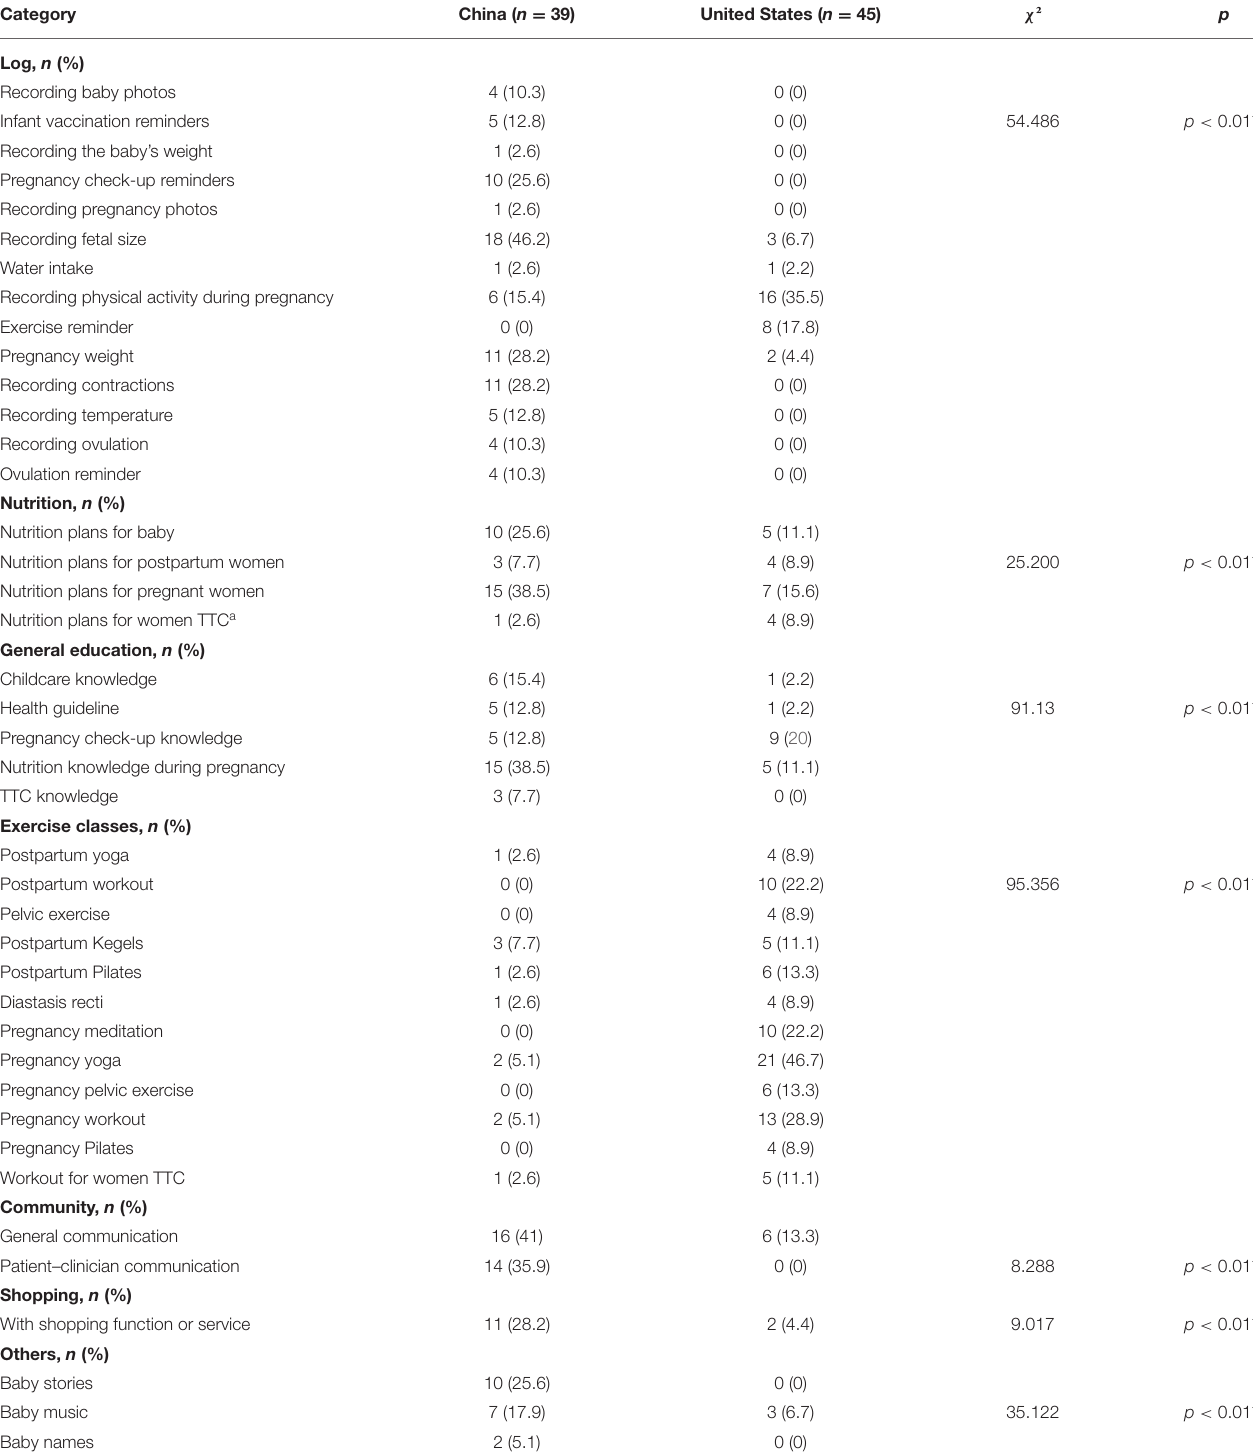
TABLE 2 | Comparison of the characteristics of the mobile apps for pregnancy and postnatal care between the US and China. Category China ( n =